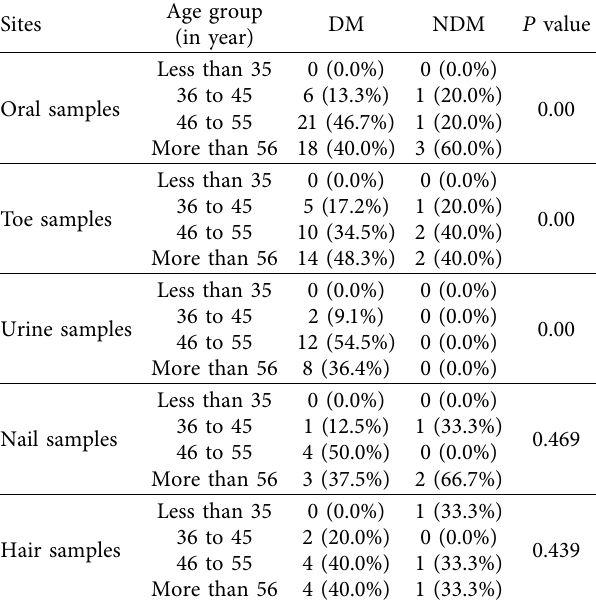
Table 2: Relation between age group and distribution of fungal isolates in study